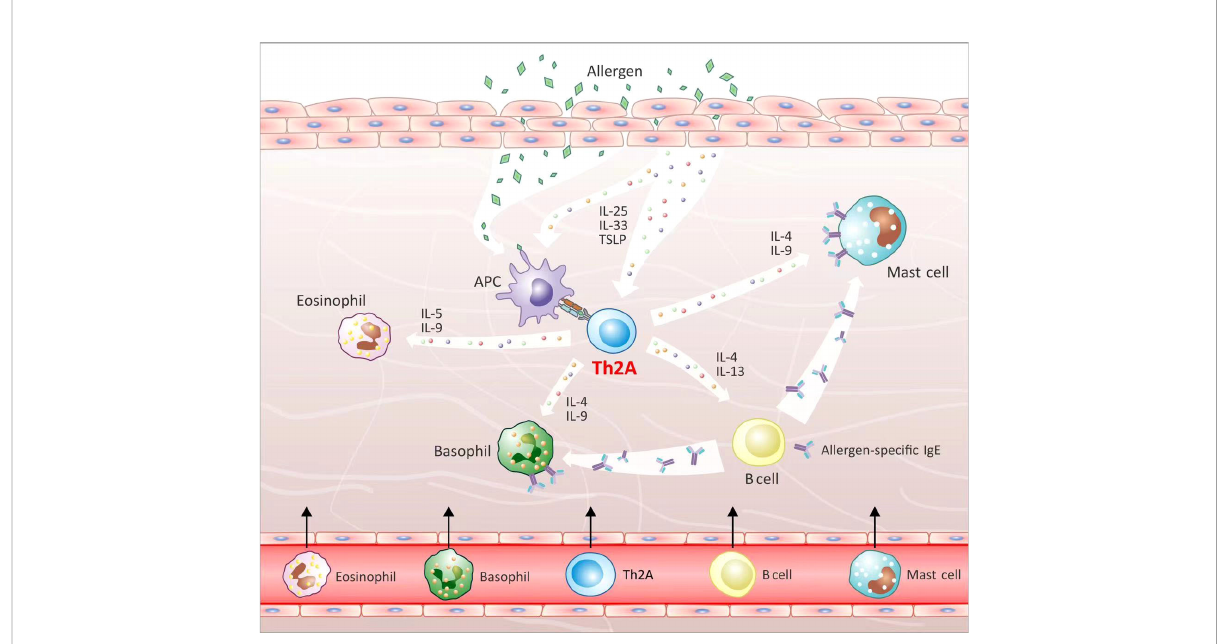
FIGURE 2 Th2A cells ’ biological function. After allergen stimulation, epithelial cells secrete IL-25, IL-33, and TSLP to activate APCs and Th2A cells. APCs present allergens to activate tissue-resident Th2A cells. Th2A cells that have been activated secrete IL-5 and IL-9, which aid in the recruitment and activation of eosinophils. Th2A cells produce IL-4 and IL-13, stimulating B cells to produce allergen-speci fi c IgE antibodies. Meanwhile, Th2A cells secrete IL-4, IL-9, and IL-10 to activate mast cells and